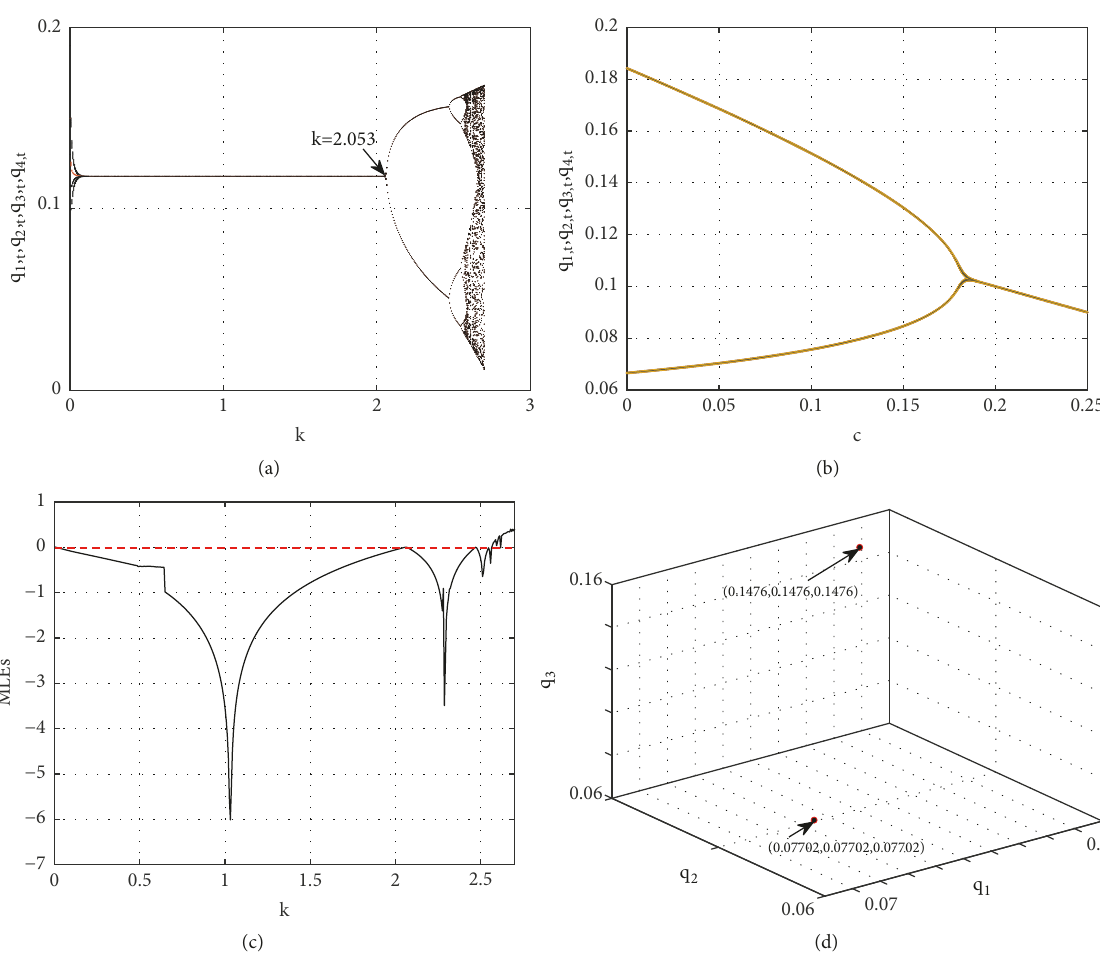
Figure 1: (a) Bifurcation diagram of system (6) with respect to 𝑘 at (𝑎,𝑐,𝛼,𝑞 0,1 ,𝑞 0,2 , 𝑞 0,3 ,𝑞 0,4 ) = (0.7, 0.11, 0.5, 0.19, 0.15, 0.13, 0.11) . (b) Bifurcation diagram of system (6) with respect to 𝑐 at (𝑎,𝑘,𝛼,𝑞 0,1 , 𝑞 0,2 ,𝑞 0,3 , 𝑞 0,4 ) = (0.7,2.2, 0.5, 0.19, 0.15, 0.13, 0.11) . (c) Maximum Lyapunov exponents with respect to 𝑘 at (𝑎,𝑐,𝛼,𝑞 0,1 ,𝑞 0,2 , 𝑞 0,3 ,𝑞 0,4 ) = (0.7, 0.11, 0.5, 0.19, 0.15, 0.13, 0.11) . (d) Phase portrait of the period 2-cycle of system (6) at (𝑎, 𝑐, 𝑘, 𝛼, 𝑞 0,1 , 𝑞 0,2 ,𝑞 0,3 , 𝑞 4 ) = (0.7,0.11, 0.5, 0.19, 0.15, 0.13, 0.11)